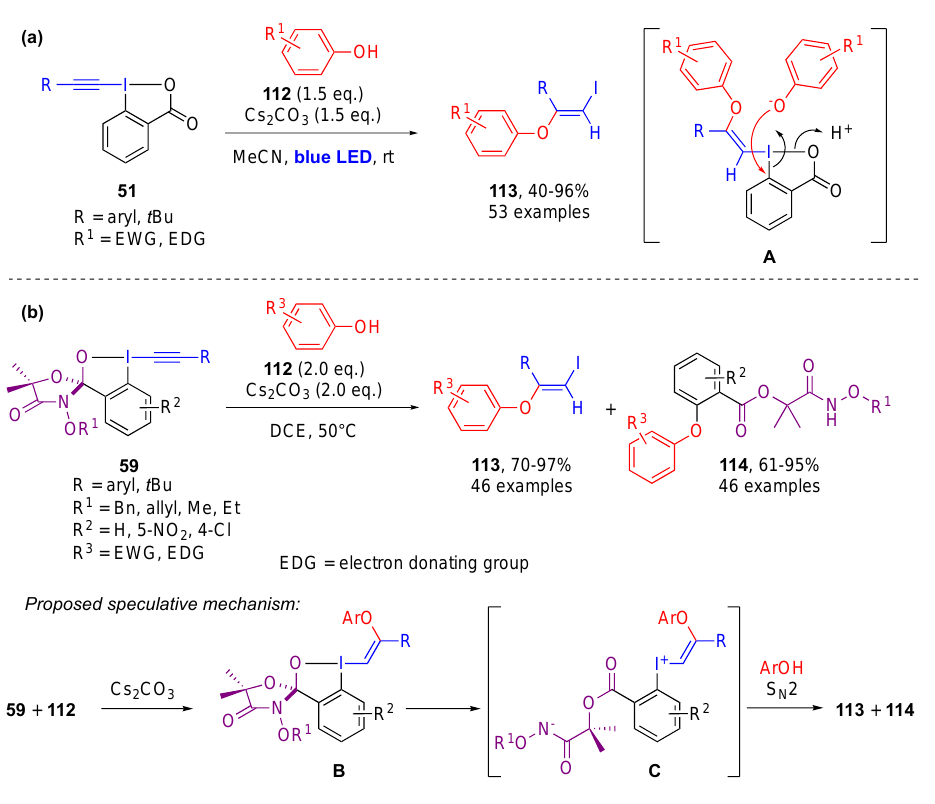
Scheme 23. Preparation of ( Z )-2-iodovinyl phenyl ether derivatives 113 and diaryl ethers 114